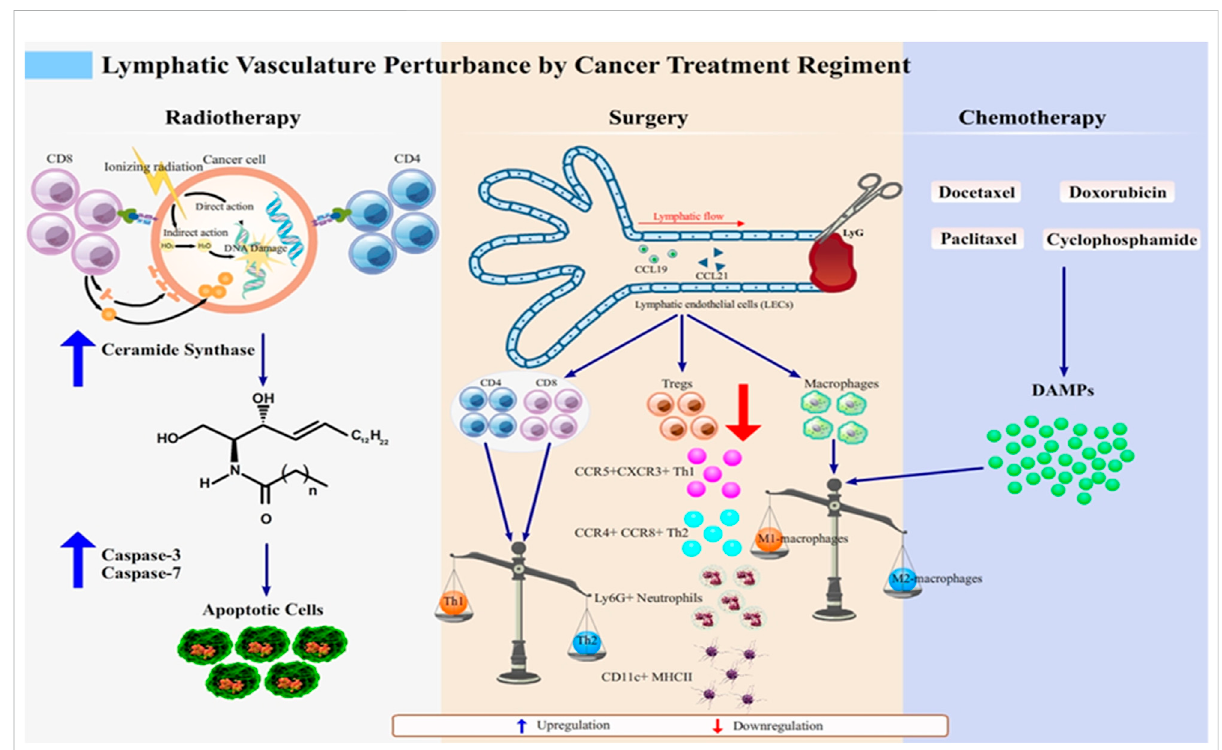
FIGURE 1 Lymphatic vasculature perturbation by anticancer regimens. Lymphedema develops after cancer treatment through various molecular events, which together highlight the disturbance of normal lymphatic physiology. Radiotherapy as an anticancer regimen enhances the expression of MHC classImoleculestoimprovetheabilityofrecognitionofcancerouscellsbyCD8 + Tcellsubset(Choietal.,2007).However,astheproximallymphatic vasculature, which is lined up by LECs, is unavoidably injured, the breaks in double-stranded DNA in irradiated LECs causes further damage to themitochondria.This damagesubsequently signalsthe denovo synthesis ofceramide that interacts with caspase-3 and caspase-7 for apoptosis of LECs. This initiates lymphatic dysfunction, which manifests as lymphedema (Overgaard, 2007; Warren et al., 2015; Mortezaee and Naja fi , 2020).Surgery and chemotherapy share their mechanisms to induce lymphedema as the imbalanced state of pro- and anti-in fl ammatory macrophages. Chemotherapeutic agents such as docetaxel, doxorubicin, cyclophosphamide, and paclitaxel (Wang et al., 2017; Roh et al., 2020) inducethereleaseofDAMPsinresponsetothein fl ammatorystateoftheaffectedtissues.DAMPsskewtheTh1/Th2balancedimmuneresponseinto the Th2 response, which causes phenotypic switch of macrophages to M2 macrophages (Swaroop et al., 2015). In surgery-induced lymphedema, phenotype shifting of not only macrophage subset but also of Tcells (CD4 + , CD8 + , and Tregs), occurs, thus mediating in fl ammation. T cells respond to this by secreting anti-in fl ammatory cytokines, IL-4 and IL-13 (Hayes et al., 2008; Degnim et al., 2012). Tregs, which phenotypically are FOXP-3 expressing CD4 + T cells, are downregulated, causing recruitment of various subsets such as CCR5+CXCR3+ Th1 and CCR4+CCR8+ Th2, Ly-6G + neutrophils,andCD11c+MHCII+dendritic cells(DCs)tothein fl amedtissue (Swaroop etal.,2015) . Altogether, thesemechanismsareattributableto lymphedema development and are promising targets for the treatment of